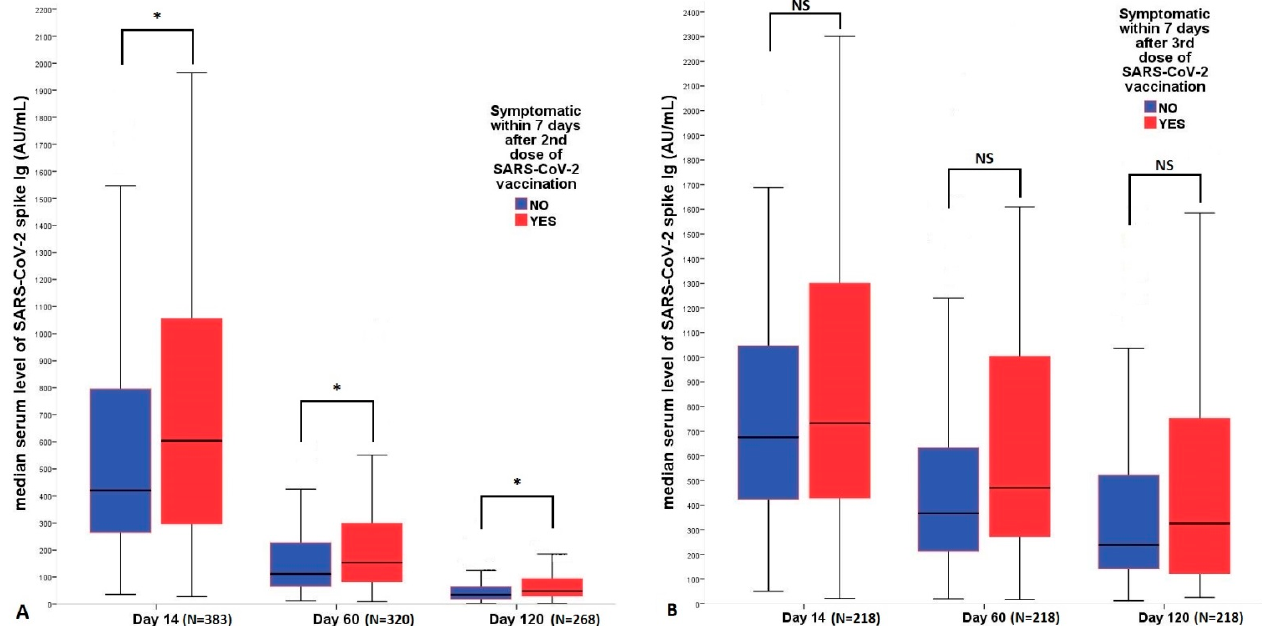
Figure 2. Correlation of antibody titers with syptomatic status after the 2nd and 3rd vaccinations. ( A ) Antibody response of symptomatic versus non-symptomatic patients at 14 (N = 383), 60 (N = 320) and 120 (N = 268) days after the 2nd vaccination, ( B ) after the 3rd dose (N = 218 at all time points). Definition of a symptomatic individual: A local or systemic adverse reaction occurring within 7 days after vaccination. Statistical analysis was performed using Mann–Whitney-U test in each group, respectively. NS, non-significant; SARS-CoV-2, severe acute respiratory syndrome coronavirus 2. * indicates p < 0.05.